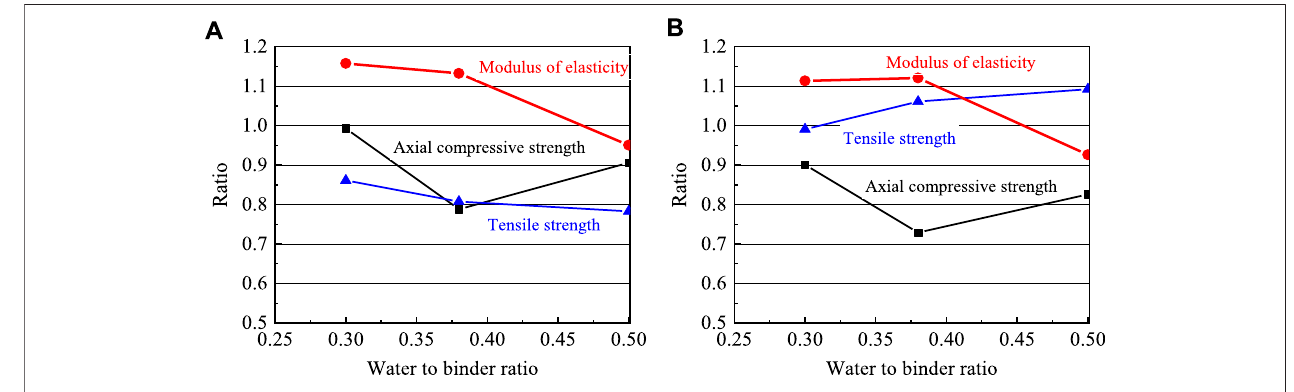
FIGURE 5 | Ratios of test to computed results for the mechanical properties at the curing age of (A) 28 days and (B) 56 days.